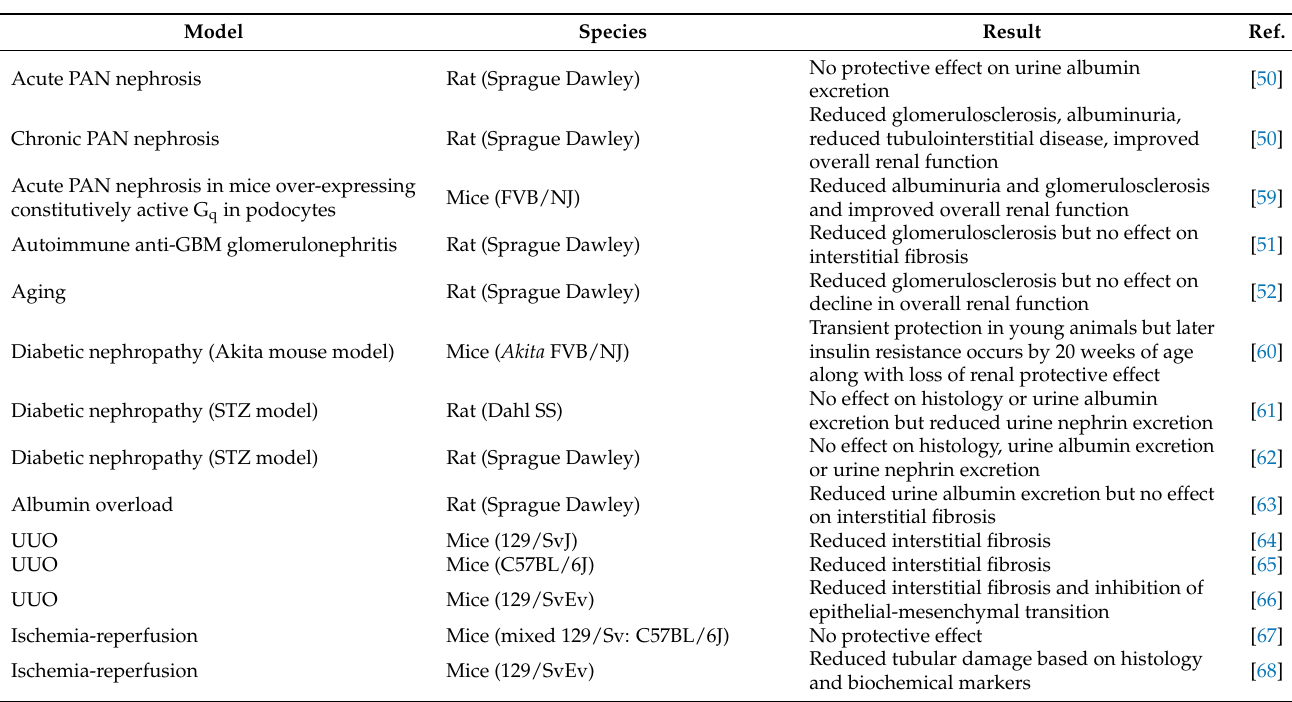
Table 1. Summary of effects of TRPC6 knockout in animal models of kidney